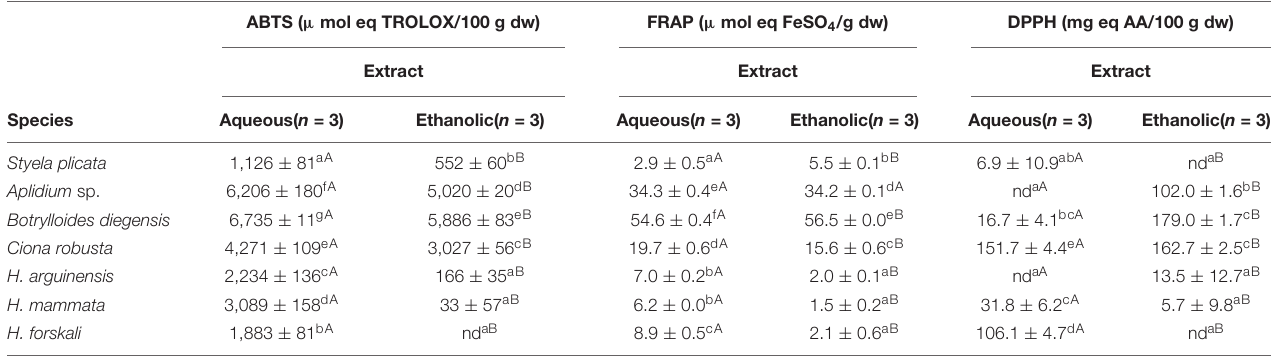
TABLE 2 | Antioxidant activity as measured by ABTS ( µ mol eq TROLOX/100 g dw), FRAP ( µ mol eq FeSO4/g dw), and DPPH (mg eq AA/100 g dw) in aqueous and ethanolic extracts of the studied tunicates and sea cucumbers.